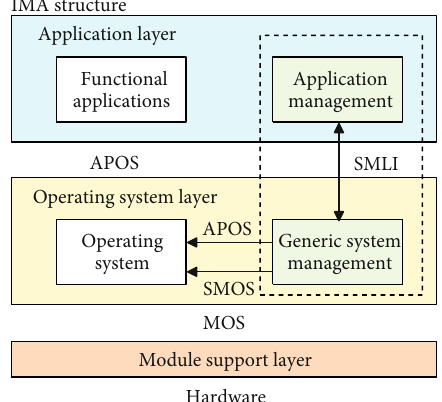
Figure 2: IMA structure of